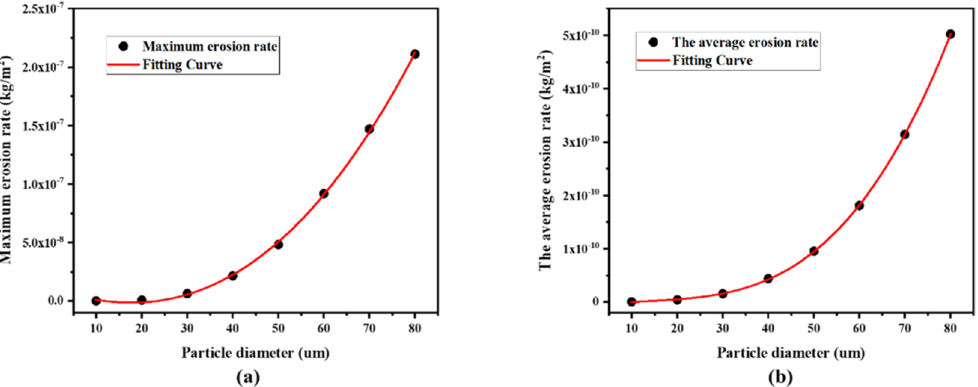
Figure 21. Fitting curve of erosion rate for different particles: ( a ) Maximum erosion rate for different particles ( b ) Average erosion rate for different particles.